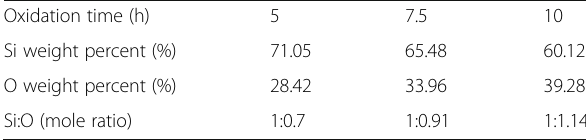
Table 2 Percentages of Si and O of different thermal oxidized Si sludge samples with different oxidation times. All data are before